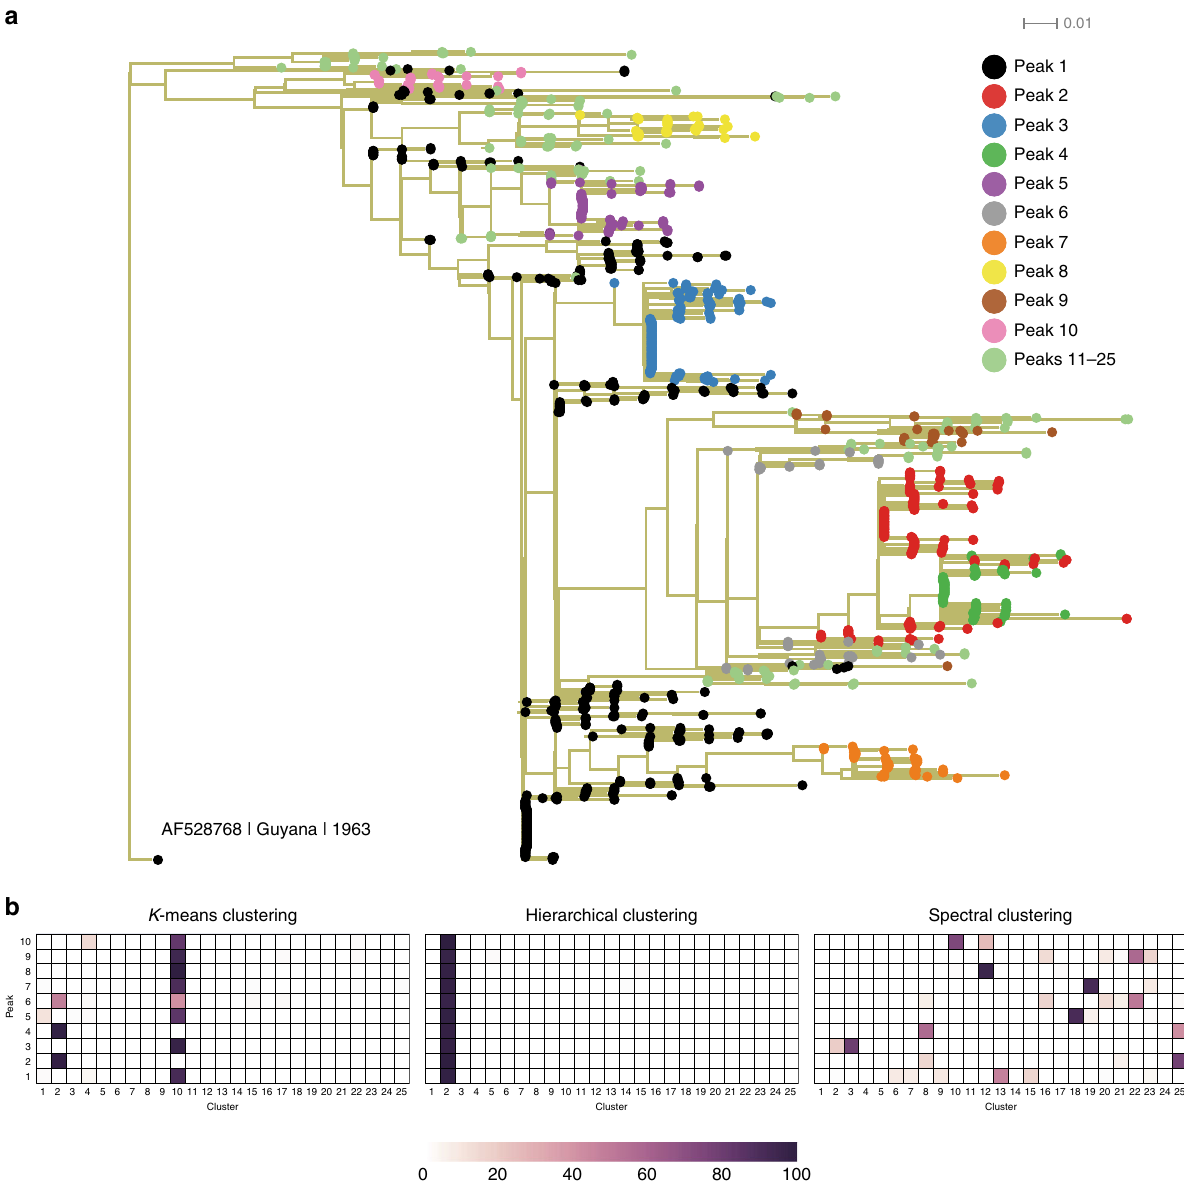
Fig. 6 Performance (and limitations) of standard phylogenetic and machine-learning methods for distinguishing natural evolution of vp1 from vaccine- induced evolution. a Vp1 phylogenetic tree constructed using PASTA 56 and rooted with the oldest available sequence (AF528768). The observed sequences appear at the leaves of the tree and are colored according to their peak number, while all the edges are drawn with khaki color. b Clusters formed using the K -means, the hierarchical, and the spectral clustering methods for the oracle case, i.e., when the number of clusters to form is set equal to the number of peaks (25) observed in the vp1 prevalence landscape. Color of a cell ( i , j ) in the heat map represents the percentage of sequences of peak j ( j = 1, 2, … , 10) that fall in a cluster i formed using the speci fi ed fi rst-order analysis involving residue-wise entropies (Supplemen- tary Fig. 6).